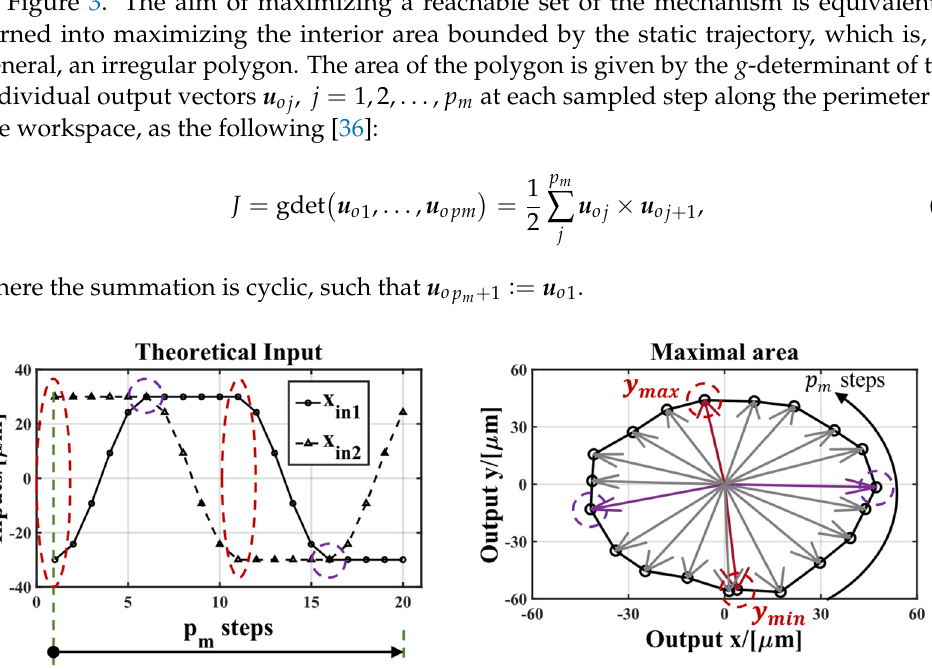
Figure 3. Proposed discretized input in this study and the corresponding L o output vectors on the perimeter of the workspace.